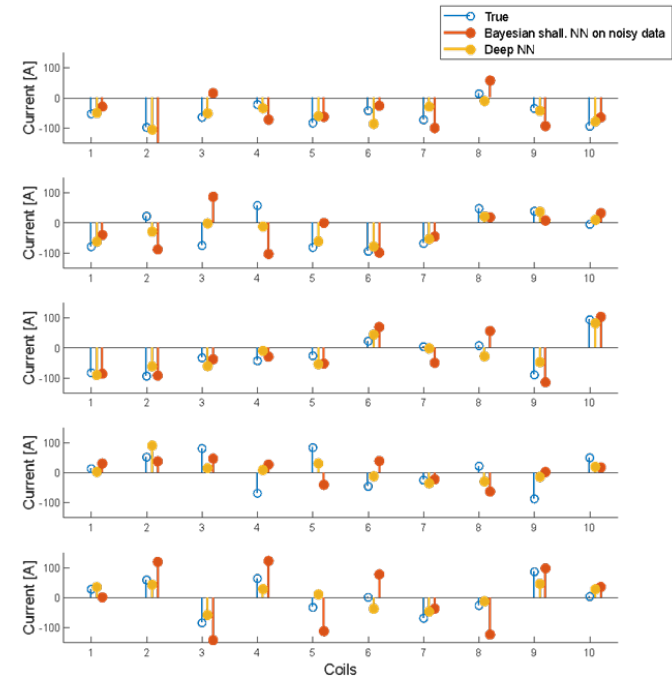
Figure 10. Five examples of reconstructed currents in the validation data set. Blue: true currents; red: reconstructions using a shallow NN trained with Bayesian rule, on noisy data; and yellow: reconstructions using a DNN with a first linear layer to encode data (60 inputs, 10 hidden neurons) and a second sigmoidal layer (from 10 hidden to 10 output neurons).